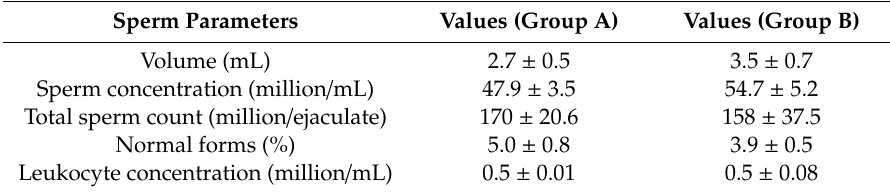
Table 1. Sperm parameters (mean ± SEM) of the two groups.